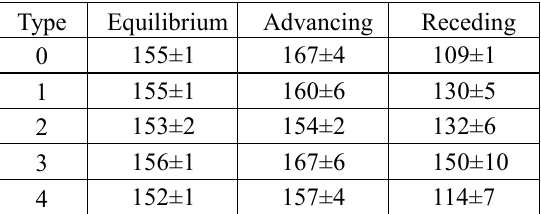
Fig. 2 Particles indicating the location of contact lines Table 2 Contact angles (in